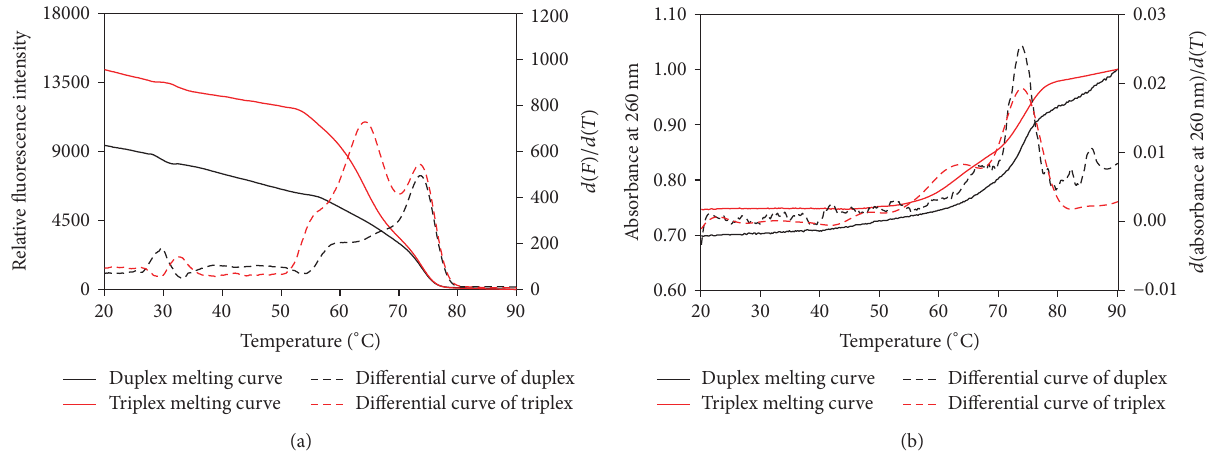
Figure 6: 𝑇 𝑚 measurement of DNA triplex by HRM (a) and by UV melting method (b). DNA duplex (black) and triplex (red) were detected in the same buffer solution (1 𝜇 M of each strand, 2.5 mM KCl, 10mM Na 2 HPO 4 , 2 mM KH 2 PO 4 , 10mM MgCl 2 , and 0.5 mM spermine (pH